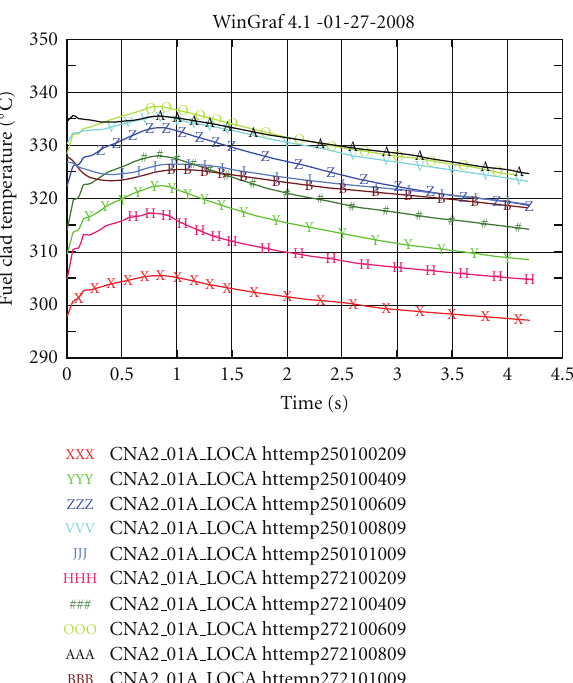
Figure 13: Fuel clad temperatures for central and hot